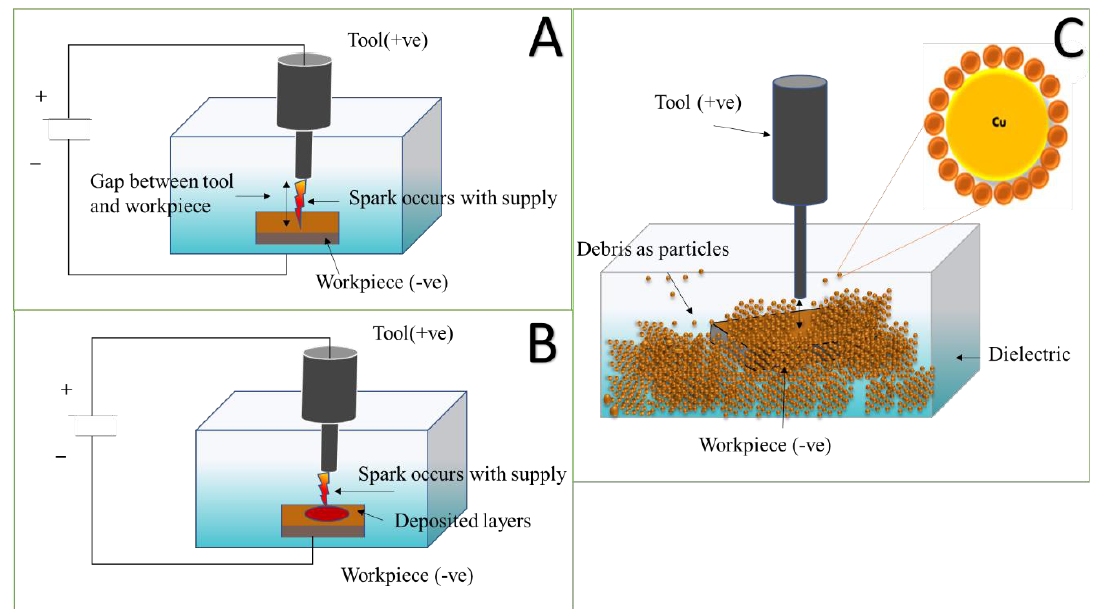
Figure 1. Working principle of EDM as particle synthesis. ( A ) EDM setup; ( B ) sparking process; ( C ) plasma region debris detaching in the form of particles.